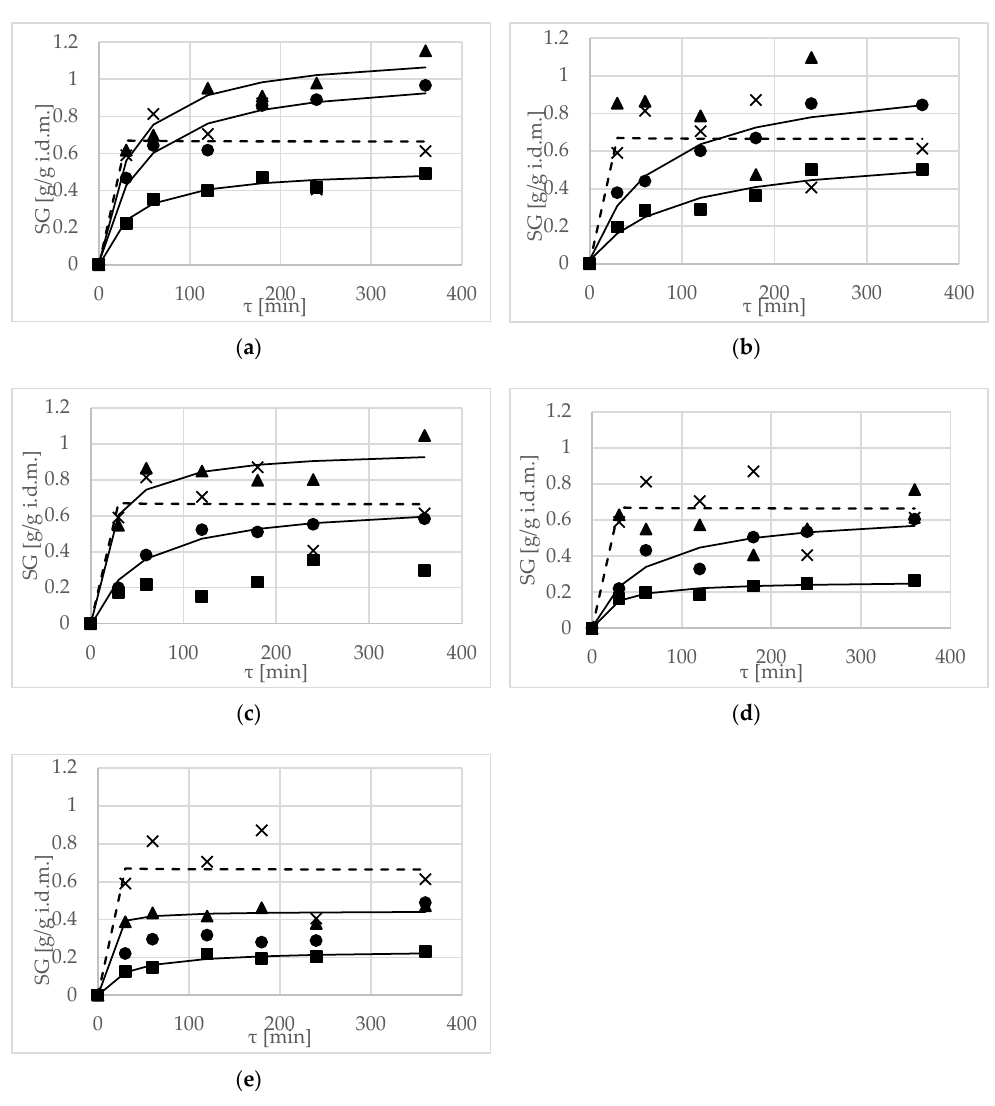
Figure 2. Solid gain (SG), kinetics at several concentrations, (20 ( ■ ), 30 (●), 40 ( ▲ ) and 50 (×) g/100g) at 40 °C, using different solutions: ( a ) erythritol, ( b ) xylitol, ( c ) maltitol, ( d ) inulin, ( e ) oligofructose. Lines are the Peleg’s model. The dotted line is the kinetic reference for sucrose. Values of k 1 , k 2 , R 2 , χ 2 , CRV and RMSE of modelling SG using Peleg’s model are shown in Table 6. According to the data in Table 6, the k 1 for all kinetic terms of mass transfer decreased with increasing concentrations of the osmotic solution, at a constant solution temperature. High values for the k 1 parameter indicated a low mass transfer rate. The k 2 parameter defines the equilibrium moisture content and soluble solids—achieved values were higher compared to modeling WL using Peleg’s model (i.e., the effect of water removal was smaller). Evaluating the goodness of fit of SG using Peleg’s model was different compared to modeling WL parameters. The use of Peleg’s modeling of OD was effective in all of the concentrations only in the case of the erythritol solution. This model can also be used for the prediction of SG at 20% and 30% concentrations, using xylitol and inulin, but not at the highest concentrations. In the cases of 20% maltitol and 30% oligofructose, values of the CRV parameter were more than 20%, indicating that the model cannot be used for modeling of SG during OD.